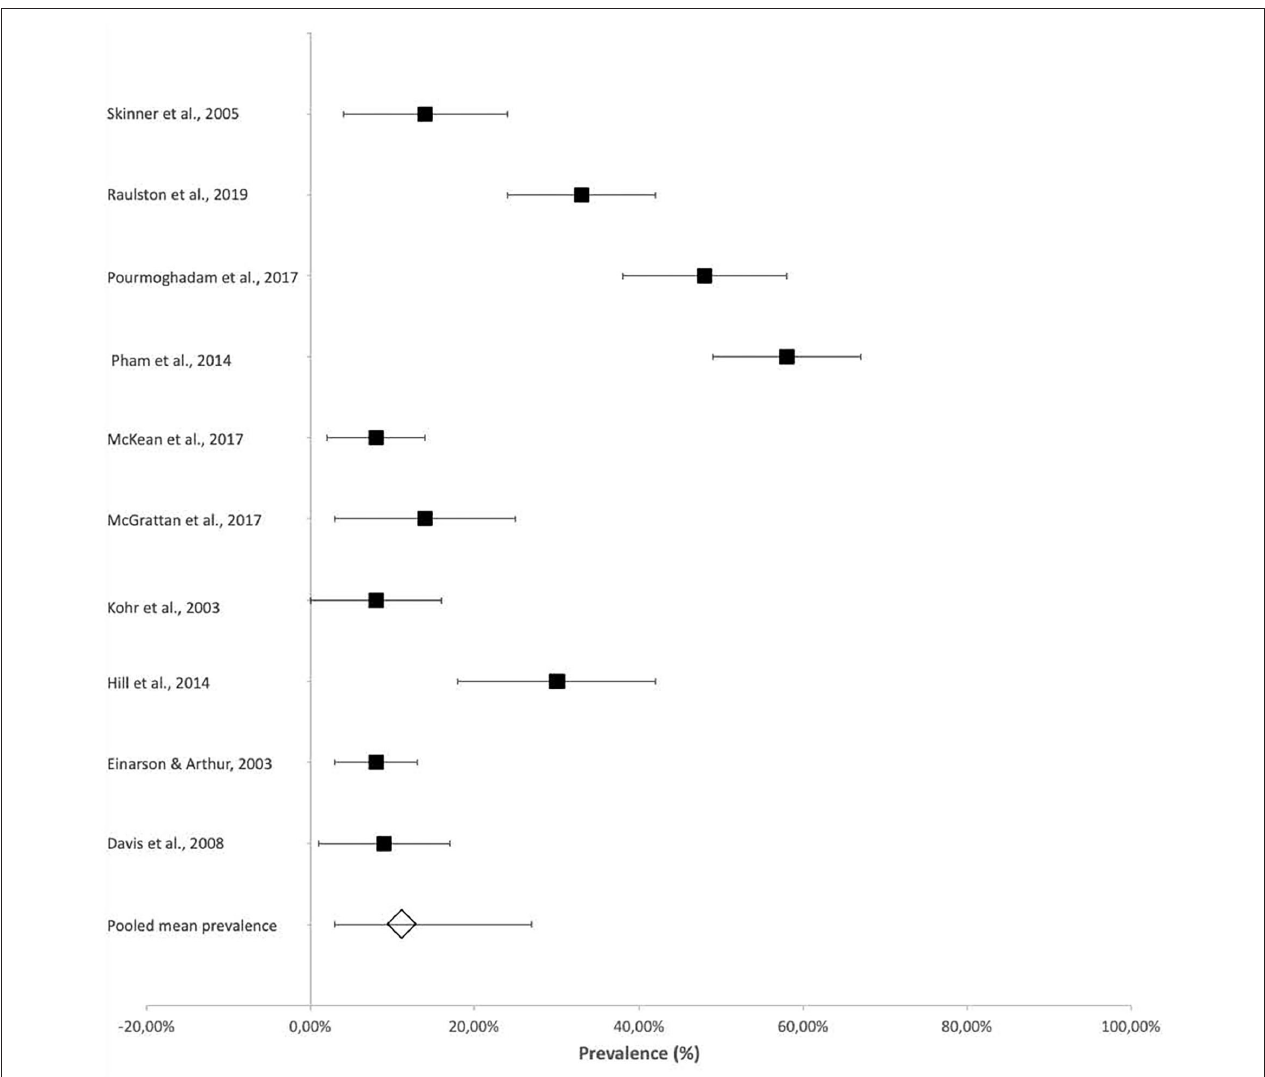
FIGURE 4 | Prevalence of vocal cord dysfunction after cardiac surgery. *Vocal cord dysfunction was assessed by